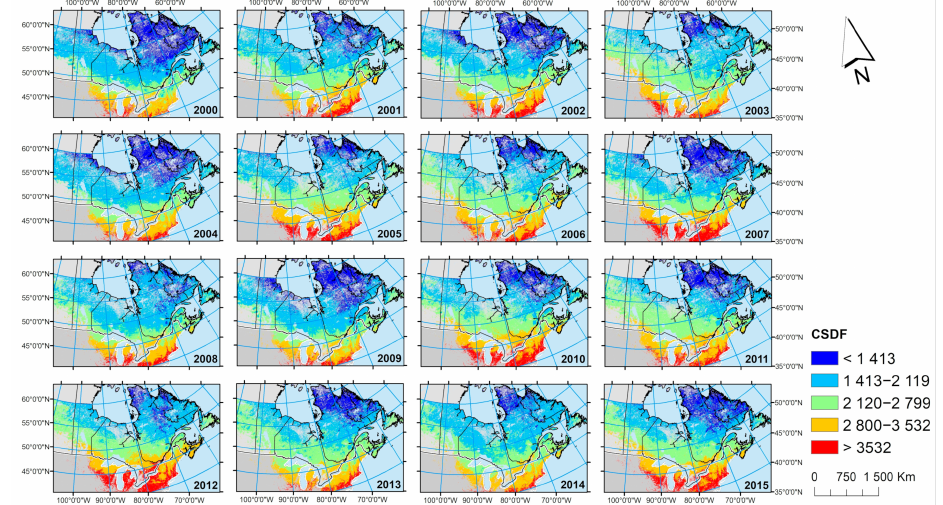
Figure 4. Annual cumulative surface degree days > 0 ◦ C of forest habitats (CSDF) in Central and Eastern Canada from 2000 to